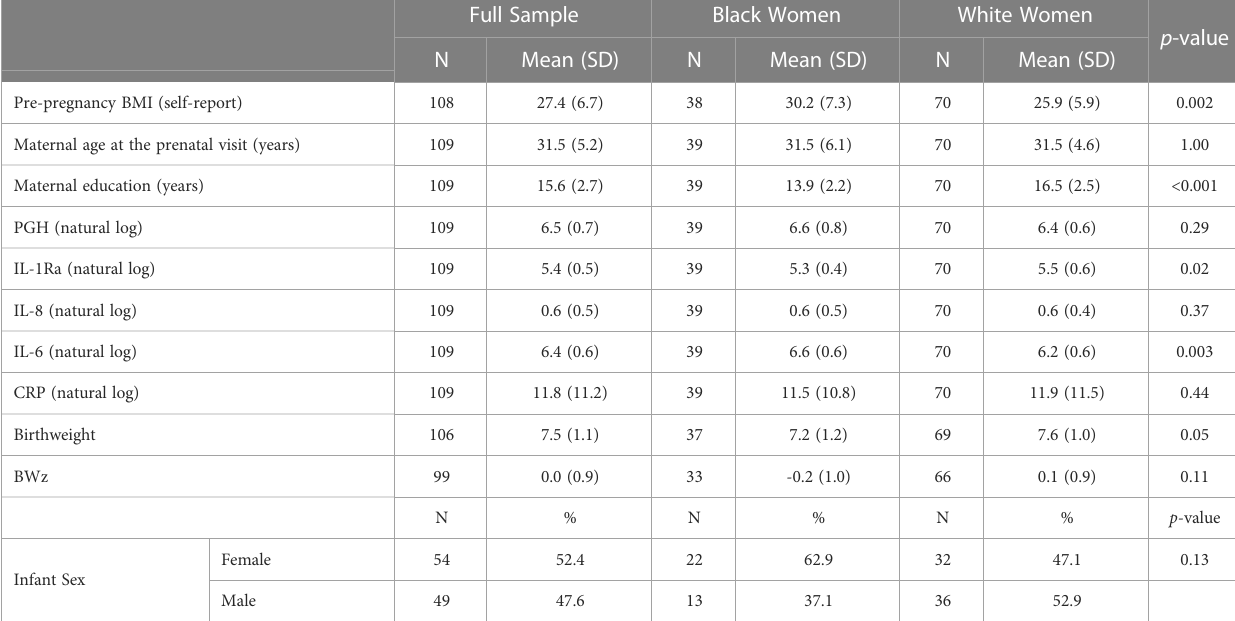
TABLE 1 Descriptive statistics of the analytic